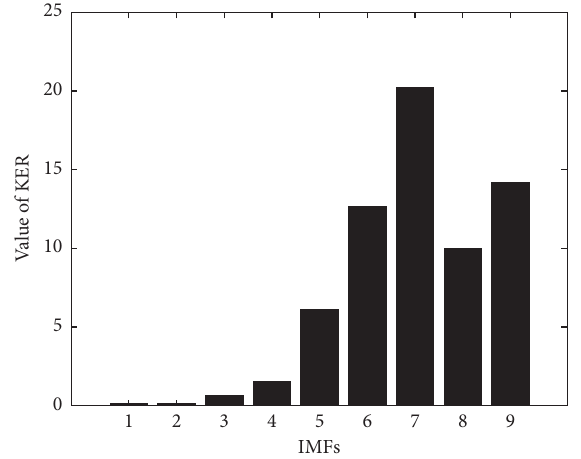
Figure 9: Values of KER for different IMFs.